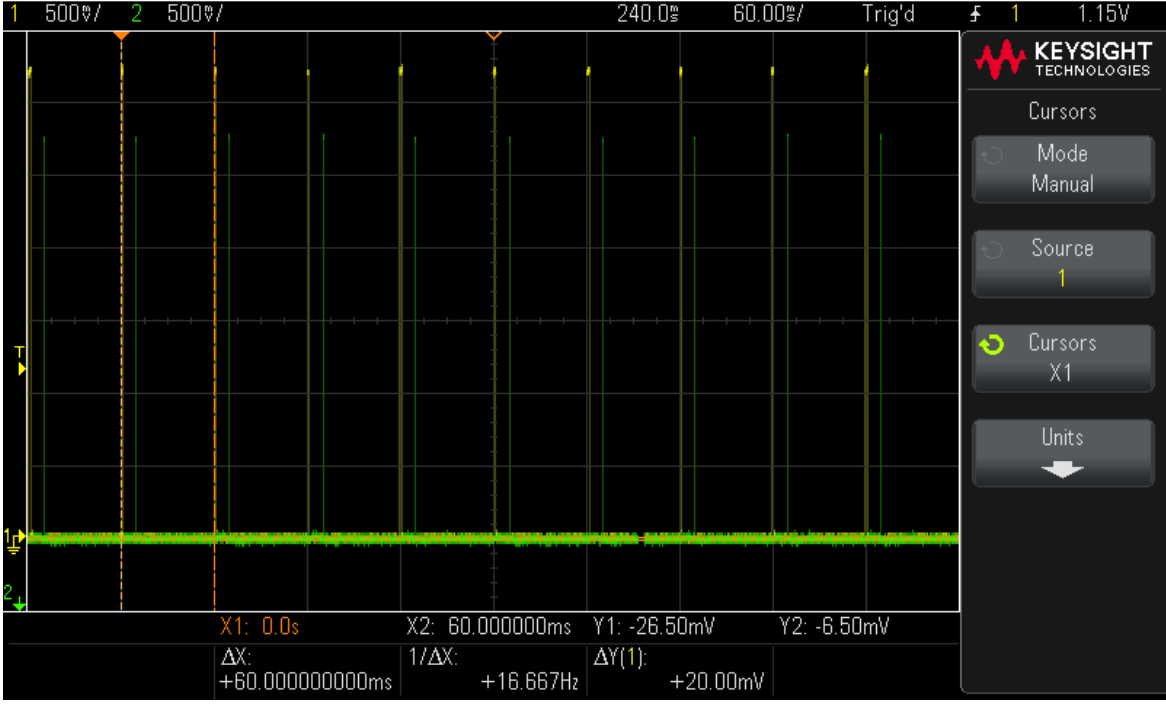
Figure 12. Periodical sending of a broadcast measurement frame at 60 ms.